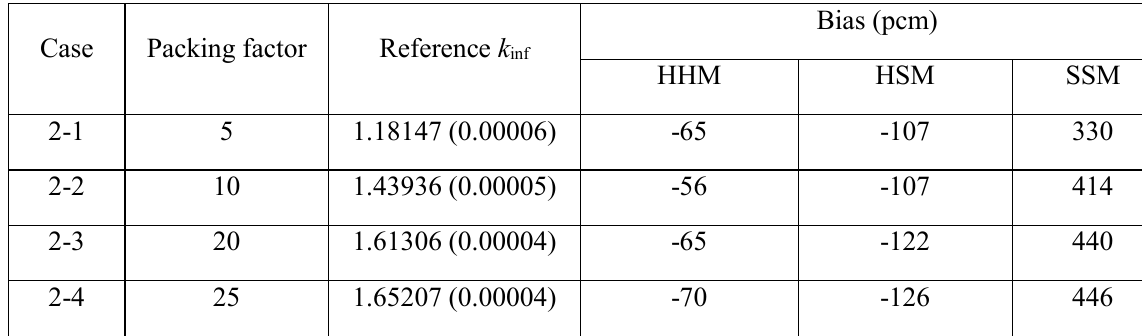
for different fuel enrichments inf